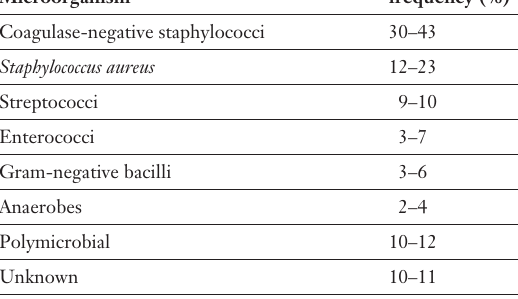
Commonly identified microorganisms causing prosthetic joint